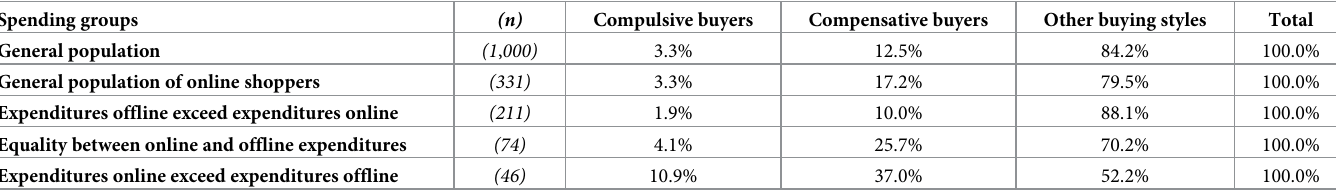
Table 3. Compulsive and compensative buyers by spending